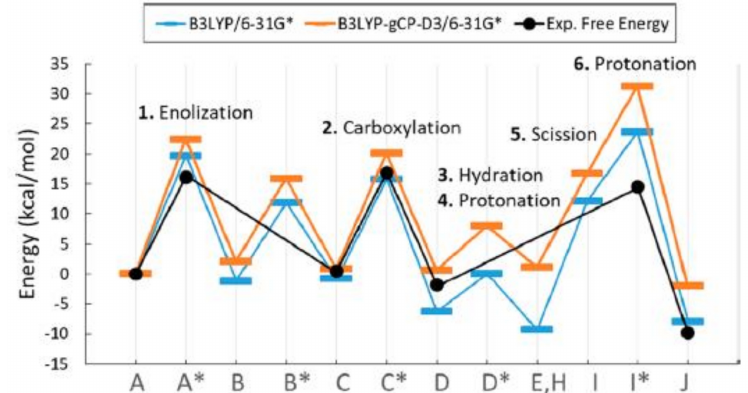
Figure 15. Blue and orange traits depict the potential energy (kcal/mol) profiles along the Ru- bisco carboxylase reaction as calculated by the B3LYP/6-31G* and the corresponding corrected B3LYP-gCP-D3 functional. Relevant reaction steps along the reaction coordinate are: (1.) RuBP enolization; (2.) carboxylation of the 2,3-enol(ate) intermediate; (3.) hydration of the 2-carboxy-3- keto-arabinitol-1,5-bisphosphate intermediate followed by protonation (4.); (5.) C2-C3 bond cleavage and (6.) protonation of C2. Black traits depict the potential energy (kcal/mol) profile indicated by experimental estimations of free-energy barriers. Figure 15 from ref. [43], used by permission of American Chemical Society (copyright ©